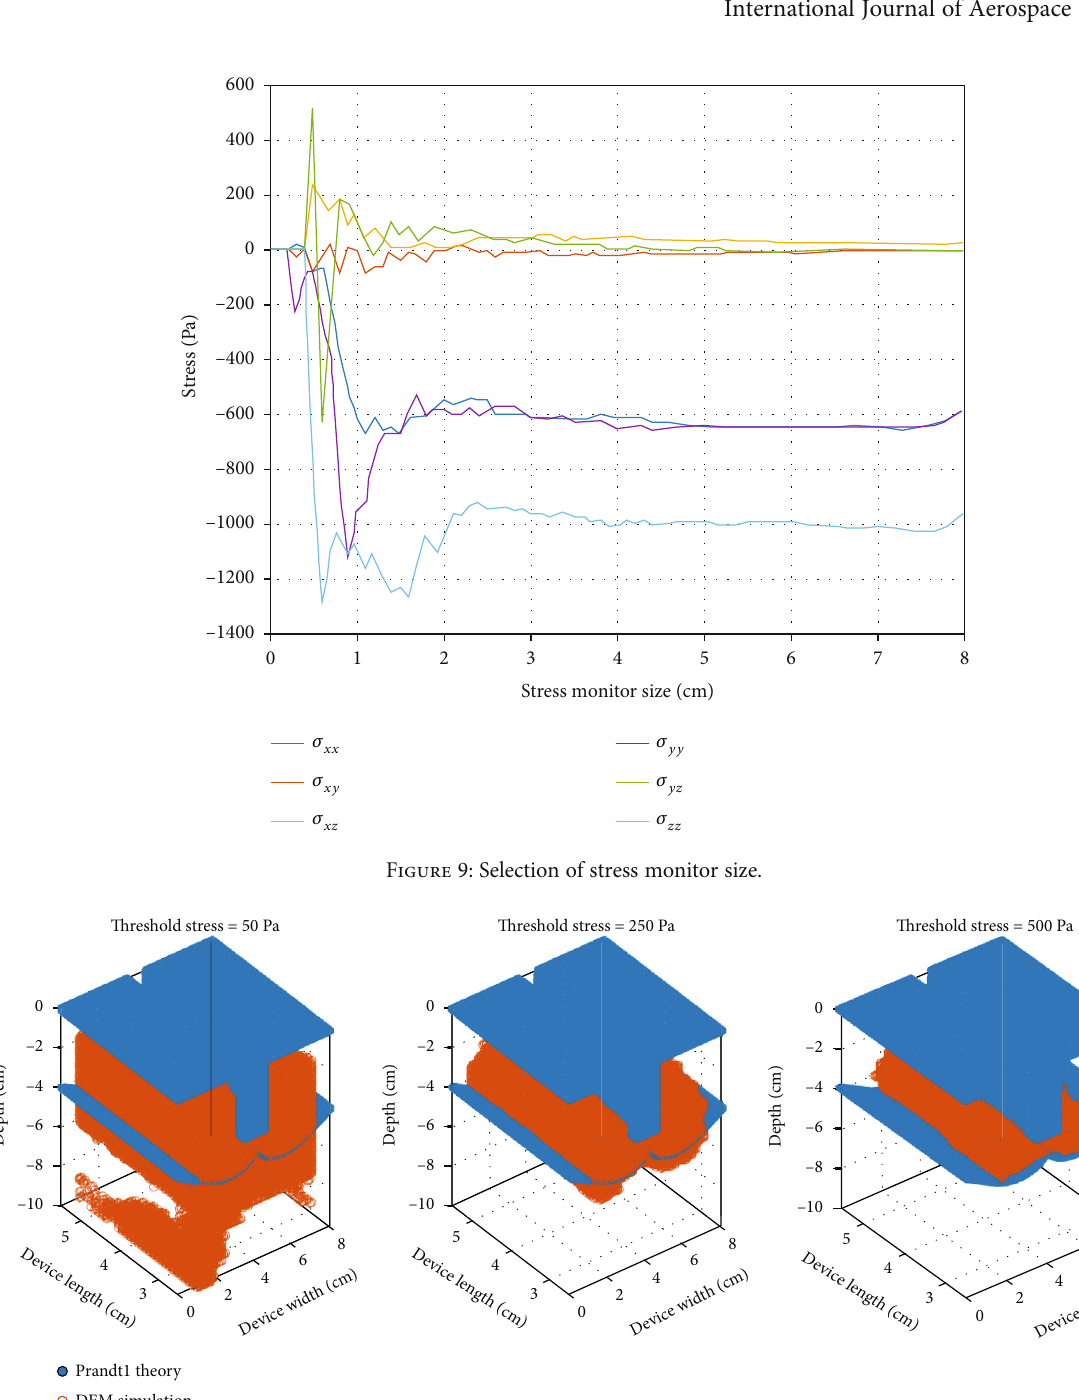
Figure 10: Di ff erent threshold stresses leading to di ff erent in fl uence